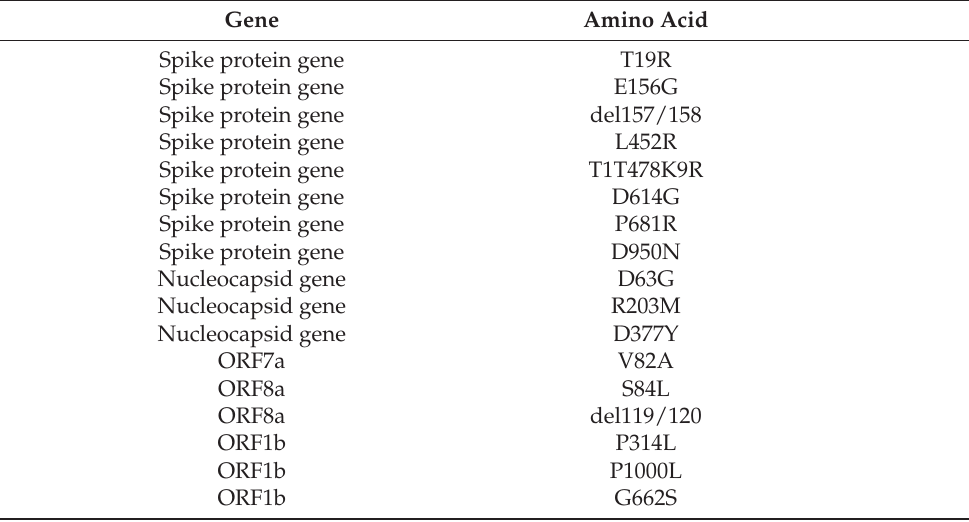
Table 1. Mutations affecting B.1.617.2 lineage [38]. ORF: open reading frames